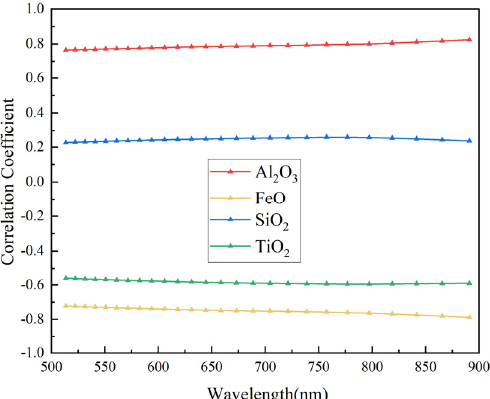
Figure 3. Linear correlation coefficients between the contents of the four oxides and LSCC reflec- tance data.